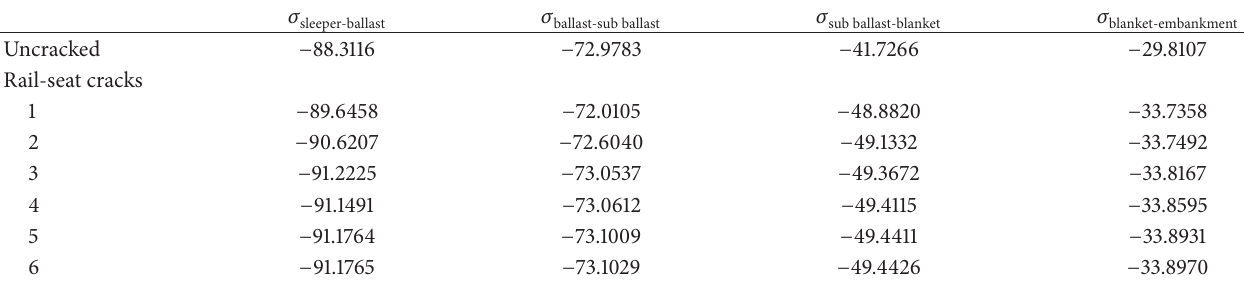
Table 9: Stresses (KPa) in the track model with 1 to 6 rail-seat cracks.